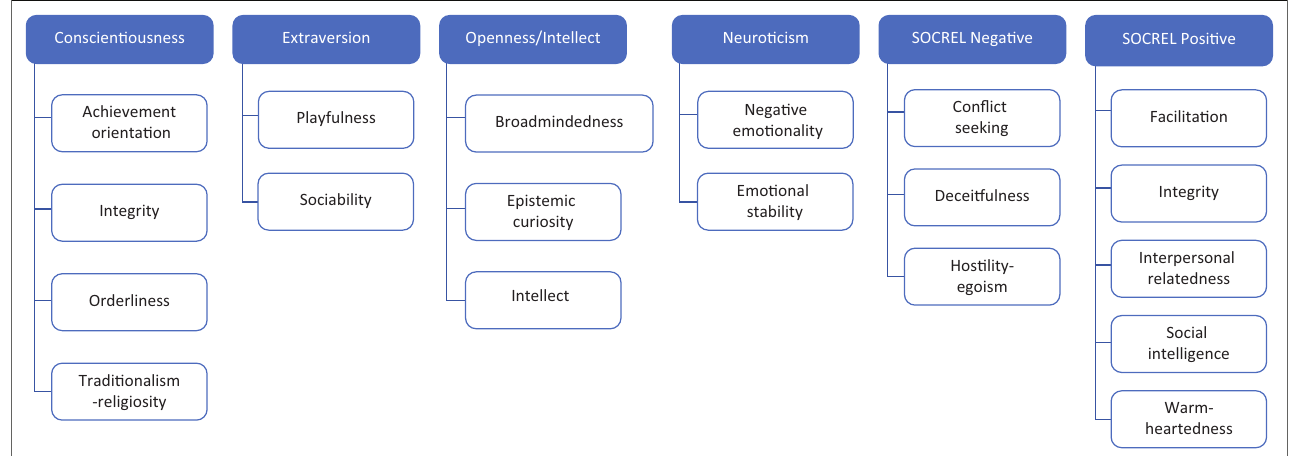
FIGURE 1: Schematic representation of the six-dimensional structure and accompanying facets of the South African Personality Inventory as identified by Fetvadjiev et al.